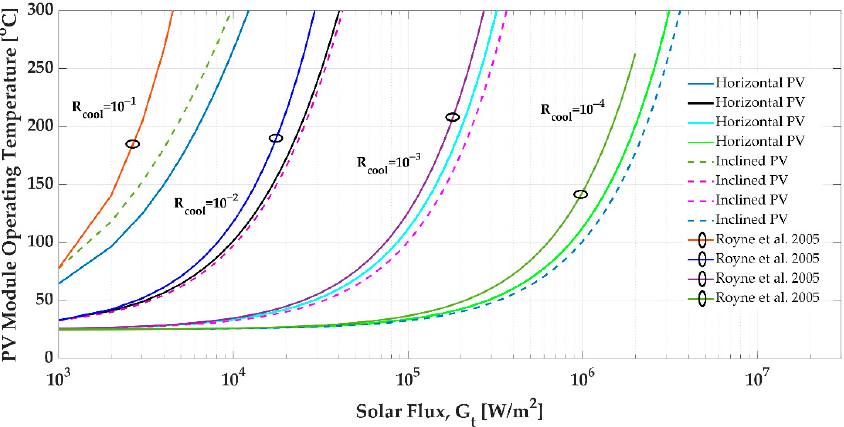
Figure 10. PV module operating temperature vs. solar flux with γ = 90 ◦ , a horizontal PV module and an inclined PV module with a tilt angle of θ = 30 ◦ , η = 12% for various values of R cool Km 2 /W. The cooling system results from [31] are presented in this figure (which has an ellipse mark on the curve) to compare the proposed model output with the literature.